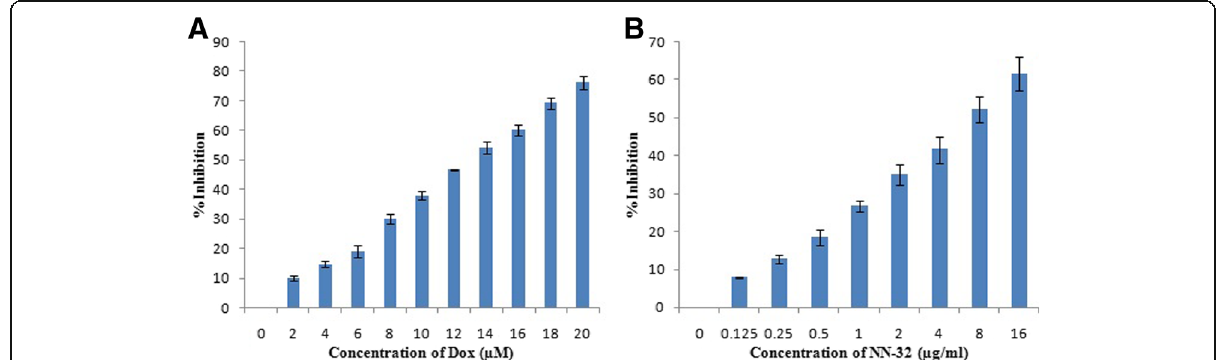
Fig. 4 Inhibition of MDA-MB-231 cells after 48 h of treatment with ( a ) Doxorubicin and ( b ) NN-32 toxin. Values are expressed as mean ± Std. Dev ( n = 3)